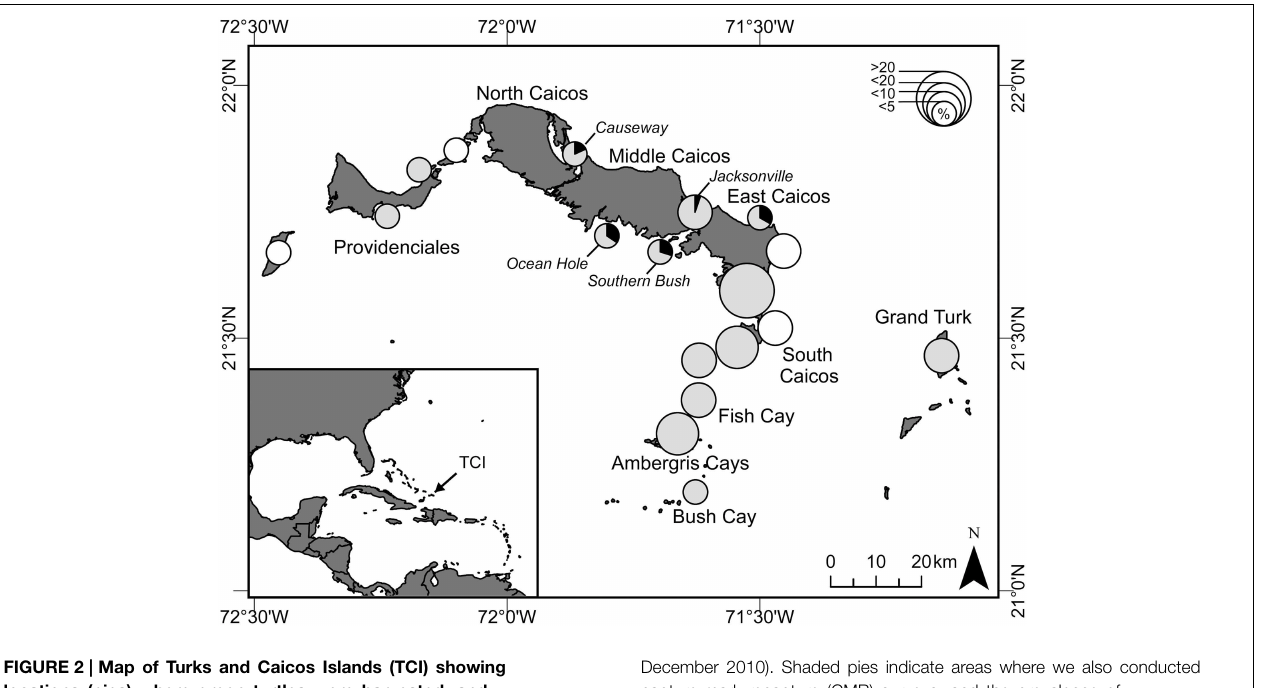
FIGURE 2 | Map of Turks and Caicos Islands (TCI) showing locations (pies) where green turtles were harvested, and prevalence of fibropapillomatosis (FP). Size of pies indicates the relative percentage of the total harvest ( < 5, < 10, < 20, and > 20%; n = 233 turtles) during 25 months of survey (November 2008 to